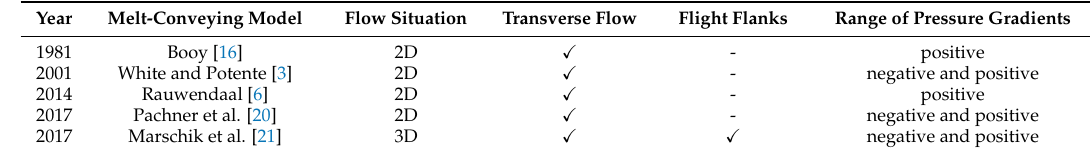
Table 1. Comparison of approximate melt-conveying models for power-law fluids.